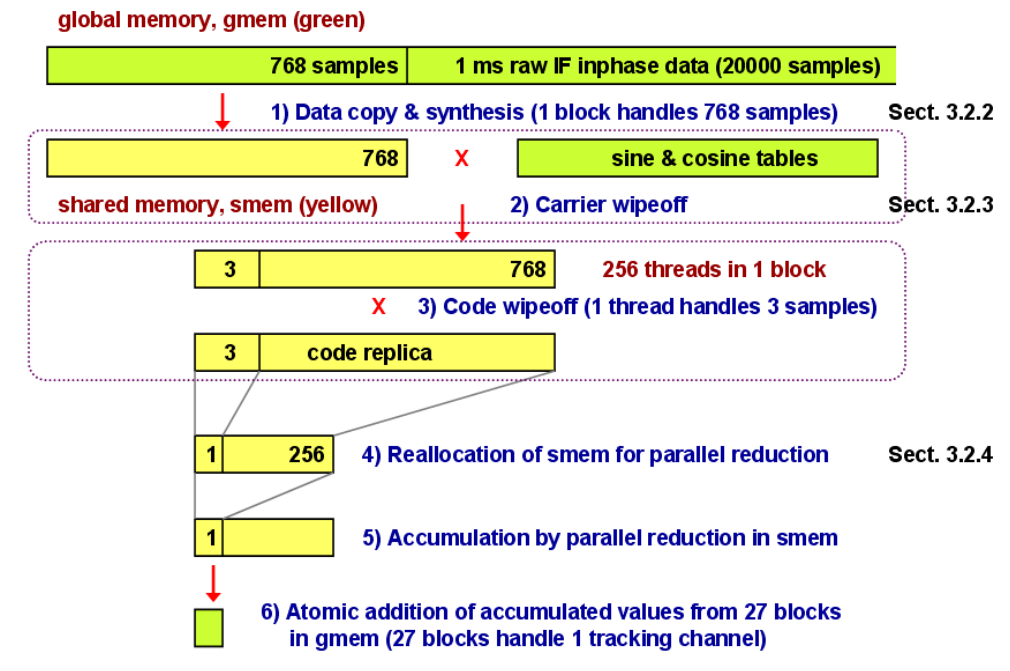
Figure 5. GPU-based parallel correlator design. The operations of single thread block (256 threads) on inphase data with a prompt C/A code replica are illustrated here. Thread blocks perform similar operations every millisecond on quadrature data with an early and a late code replica as well. Total 27 thread blocks are needed for each tracking channel, and total 60 tracking channels are needed for the CRPA processing.